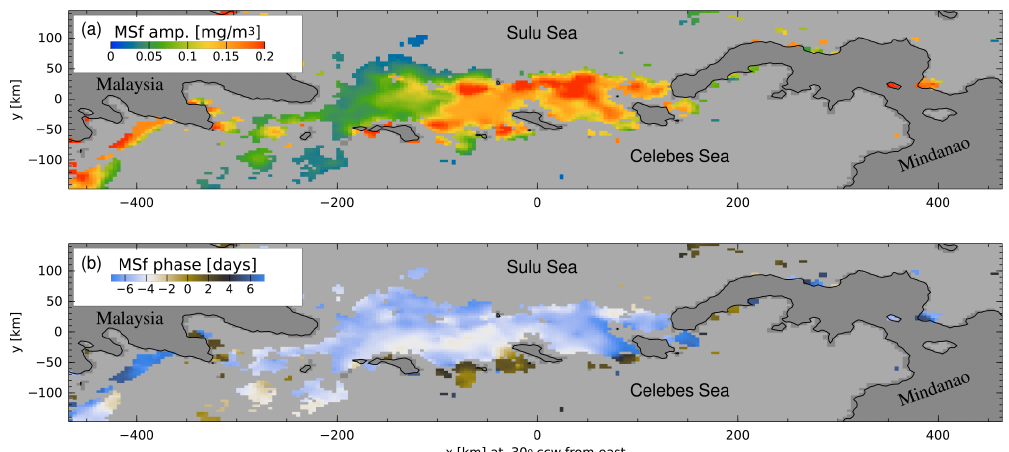
Figure 4. (a) Amplitude and (b) phase of the fortnightly MS f harmonic constants of Chl a along the Sulu Archipelago (indicated in Fig. 1).